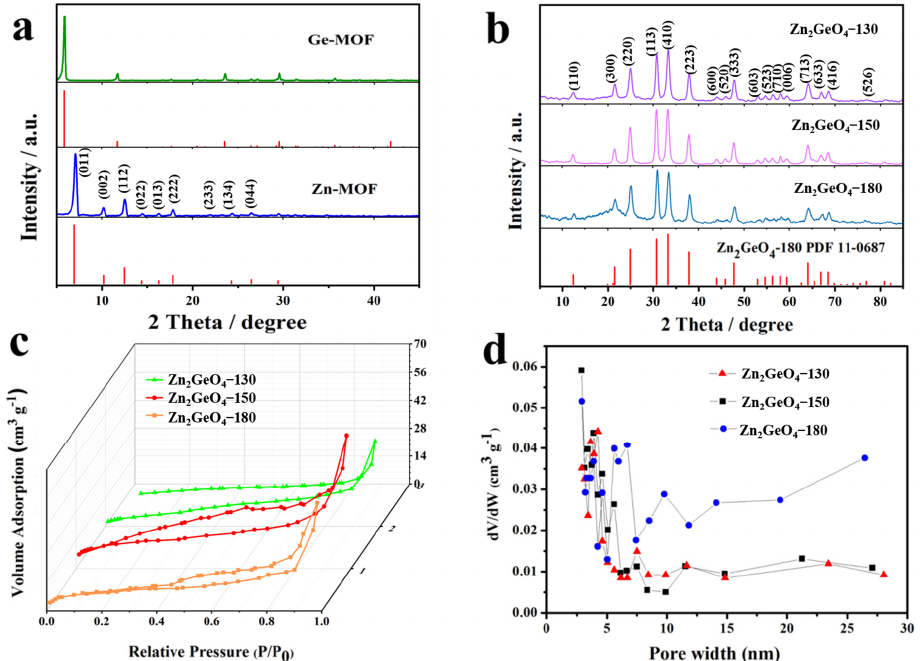
Figure 2. ( a ) XRD curves of Ge-MOF and Zn-MOF, ( b ) XRD curves of Zn 2 GeO 4 -130 and Zn 2 GeO 4 -150 and Zn 2 GeO 4 -180. ( c ) Nitrogen adsorption/desorption isotherm of the Zn 2 GeO 4 -130 and Zn 2 GeO 4 -150 and Zn 2 GeO 4 -180, ( d ) the corresponding pore size distribution curves.